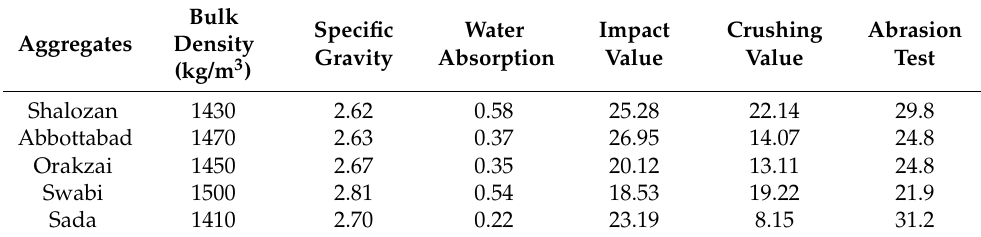
Table 5. Physical properties of tested